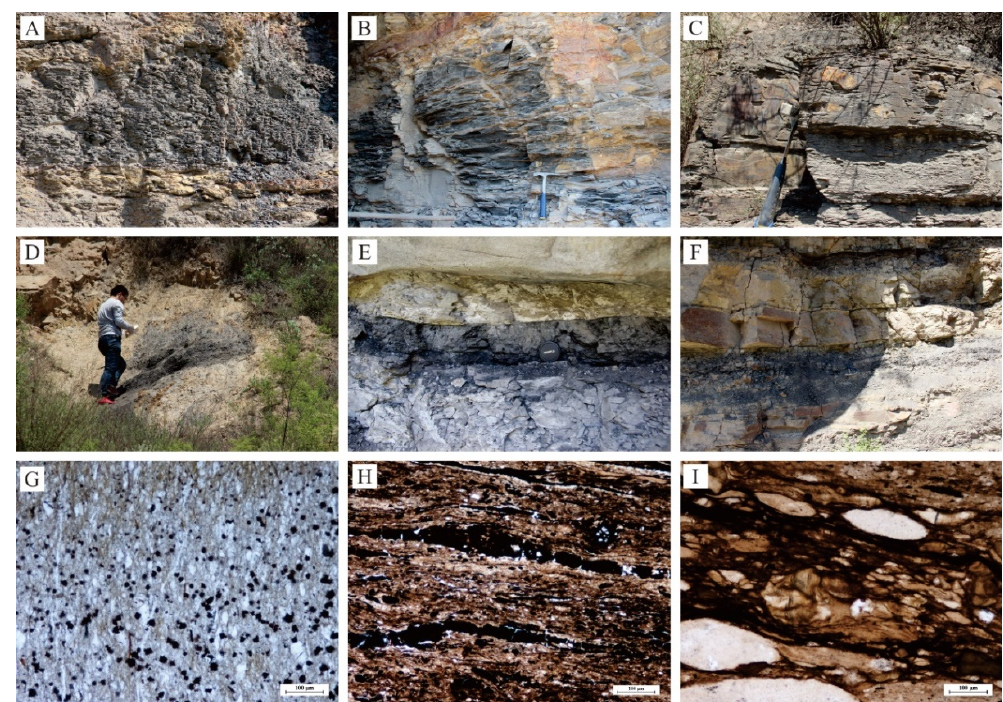
Figure 2. Outcrop photos and micrographs of the studied outcrop: ( A ) thin black shale at the lower part of the Benxi Formation; ( B ) thin black shale at the upper part of the Benxi Formation; ( C ) black shale with calcareous concrete at the Taiyuan Formation; ( D ) black shales at the 2nd Member of the Shanxi Formation; ( E ) black shale with coal seams at the 1st Member of the Shanxi Formation; ( F ) black shale at the top of 1st Member of the Shanxi Formation; ( G ) micrographs of shale at the Benxi Formation, organic matter grains are shown in black; ( H ) micrographs of shale at the 1st Member of the Shanxi Formation, organic matter distribute parallel with clay minerals; ( I ) micrographs of shale at the 1st Member of the Shanxi Formation, showing lenticular clay minerals encased within layer-like organic matter.